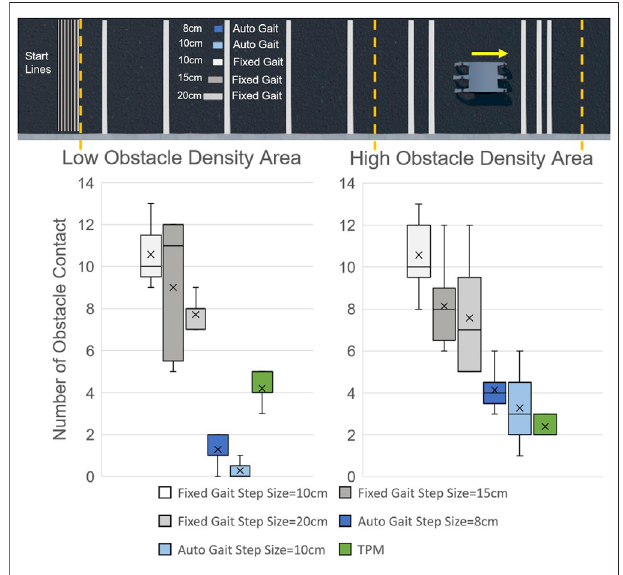
FIGURE 13 | Result of different